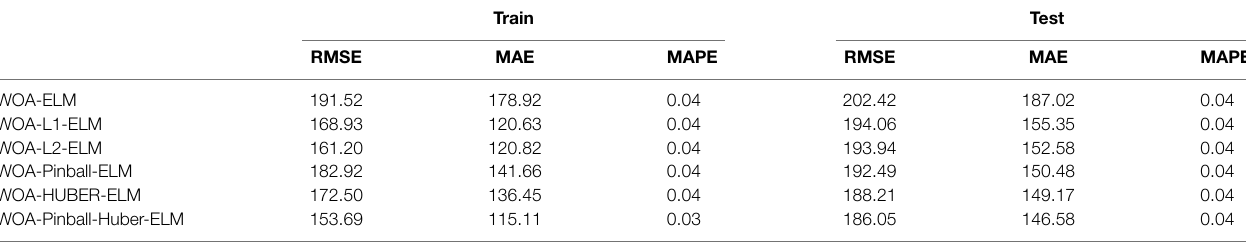
TABLE 2 | Evaluation index of Nanjing data is obtained from three prediction algorithm experiments. Train Test RMSE